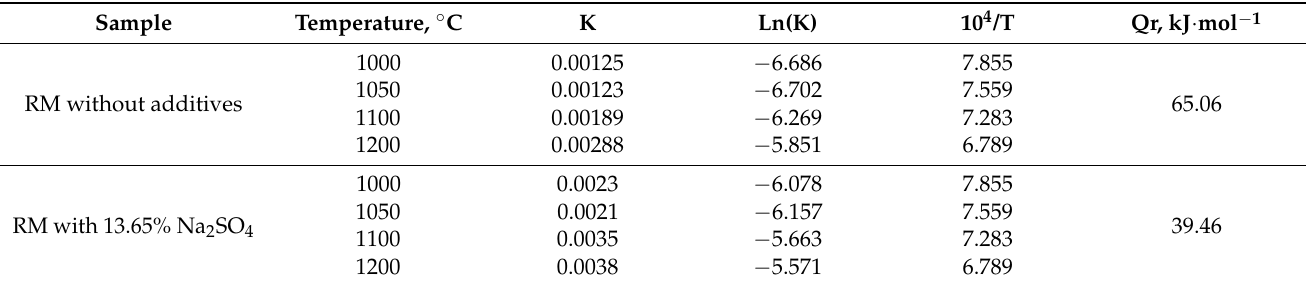
Table 4. Kinetic parameters of the reduction